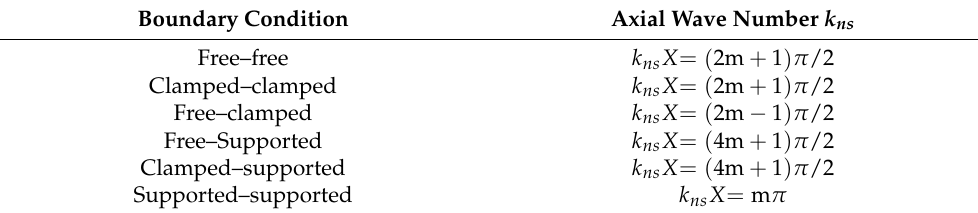
Table 1. The calculation method of the axial wave number under different boundary conditions. Boundary